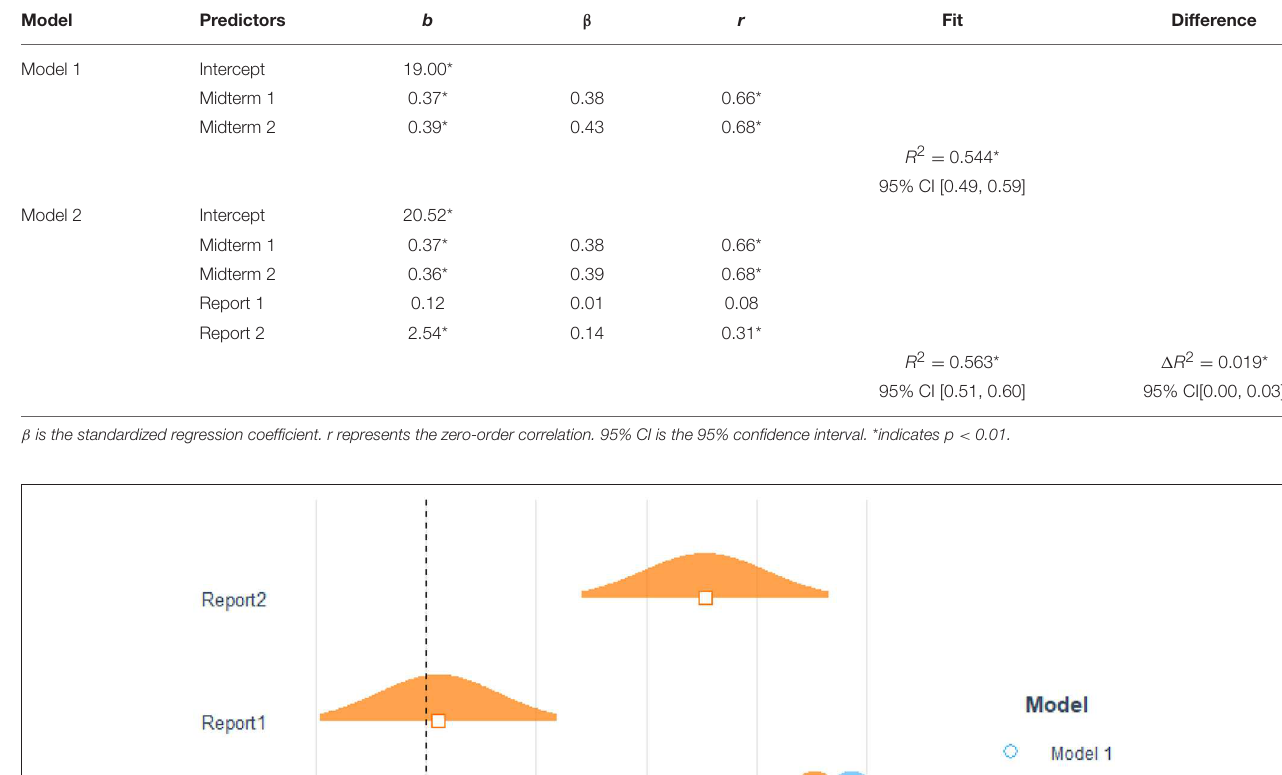
TABLE 3 | Hierarchical regression results for study 1.